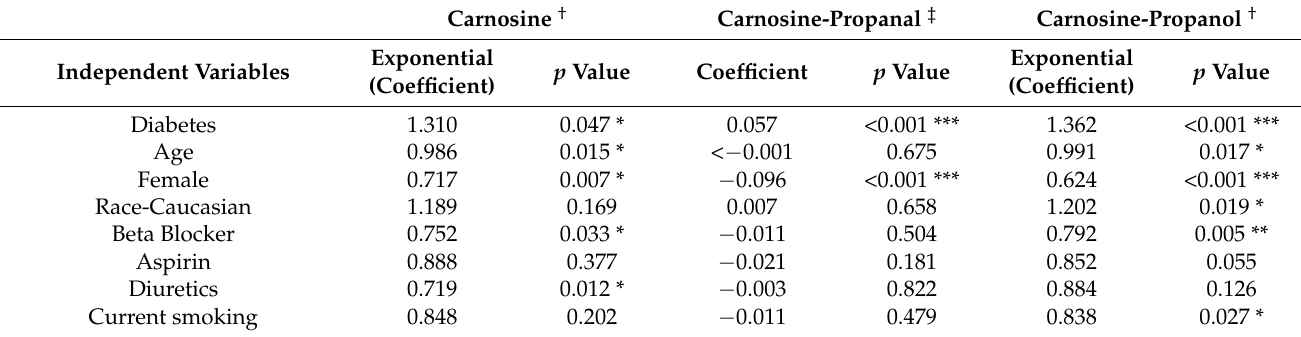
Figure 1. Illustrated are box plots demonstrating the associations between carnosine ( A , D ), carnosine-propanal ( B , E ), and carnosine-propanol ( C , F ) with diabetes (top row: A – C ) and HDL (bottom row: D – F ). * p < 0.05; ** p < 0.01. Table 2. Characteristics of Study Participants Stratified by Urinary Levels of Carnosine-Propanal. Table 4. Association of Carnosine, Carnosine-Propanal, and Carnosine-Propanol with Diabetes. Carnosine † Carnosine-Propanal ‡ Carnosine-Propanol